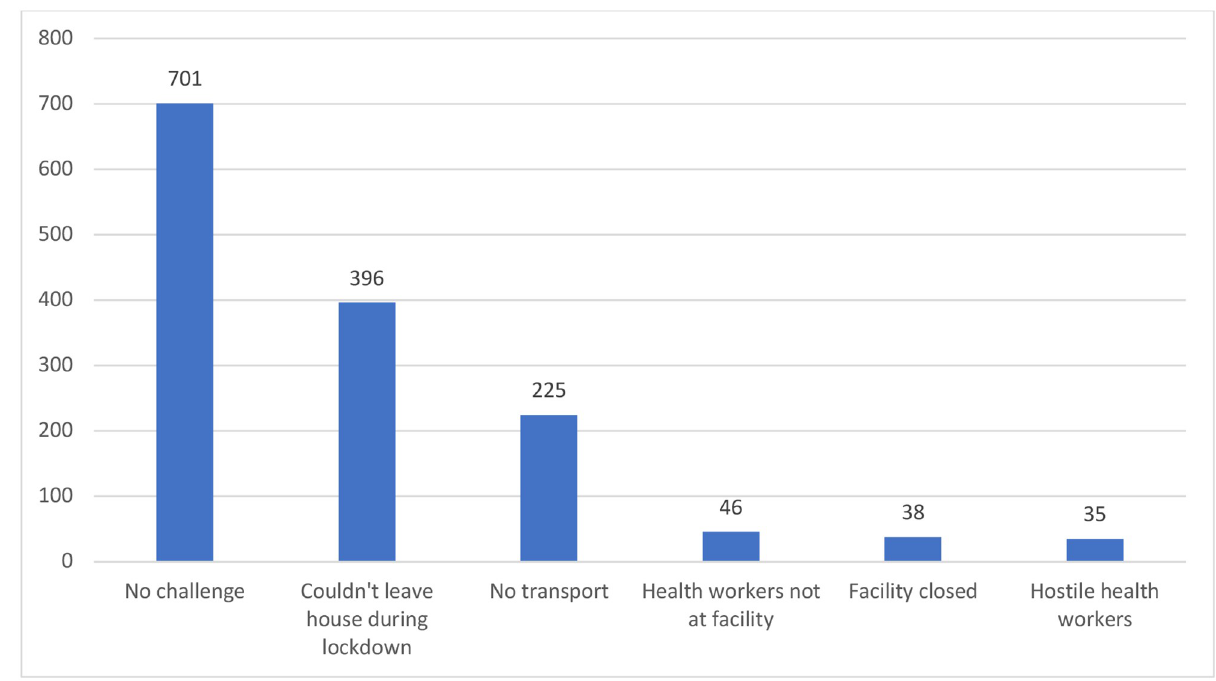
Fig 2. Challenges in accessing RMNCH services since the COVID-19 outbreak in